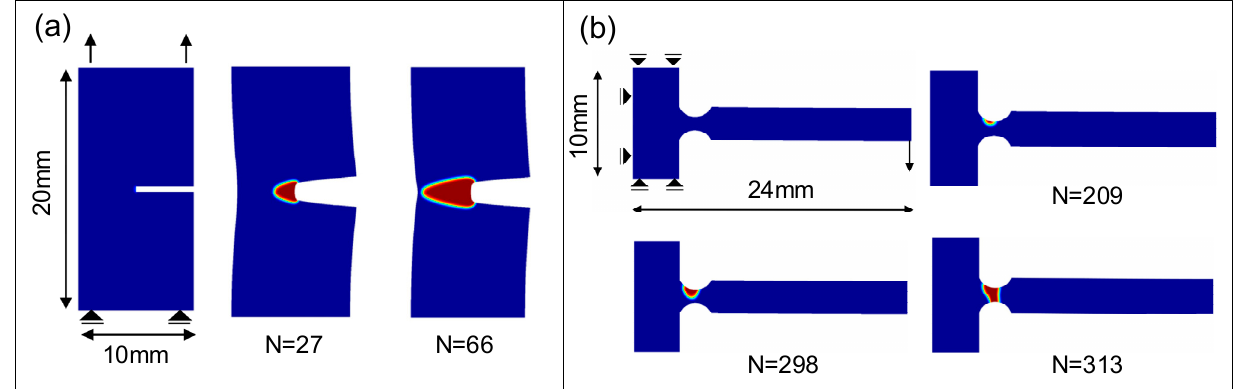
Figure 6. Hyperelastic fracture. ( a ) A single edge notched plate model and ( b ) a bending beam model [44].